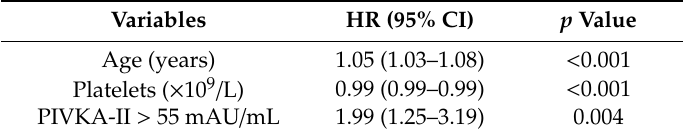
Table 6. Multivariate analysis for factors associated to HCC development.